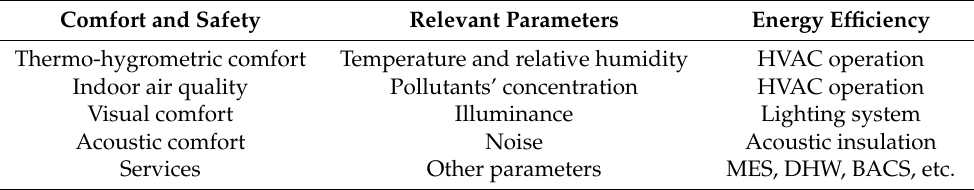
Table 1. The problem of balancing occupants’ comfort and energy use in